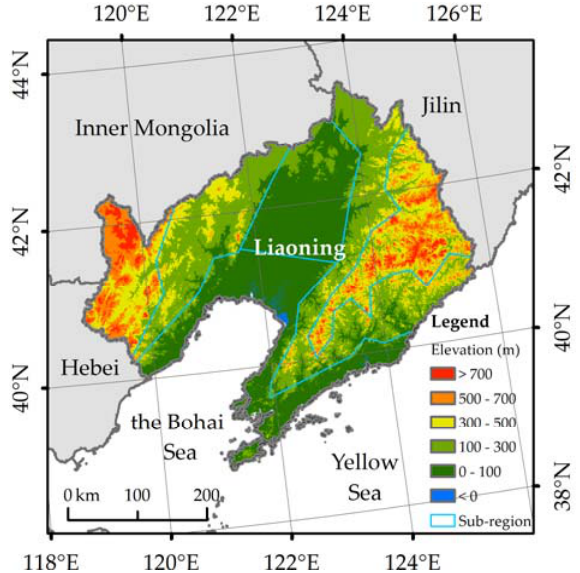
Figure 1. The location and terrain of the study area.